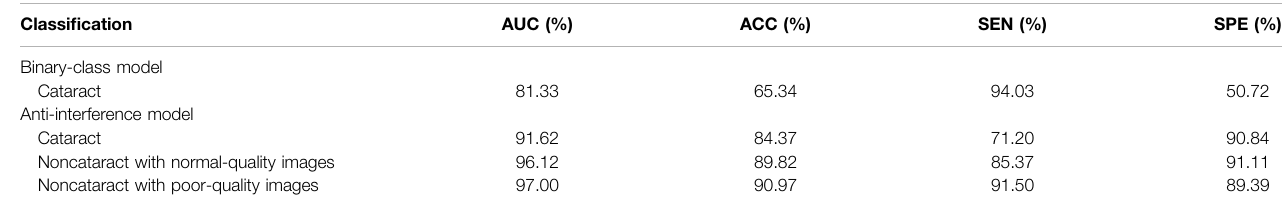
AUC, area under the curve; ACC, accuracy; SEN, sensitivity; SPE, speci fi city.